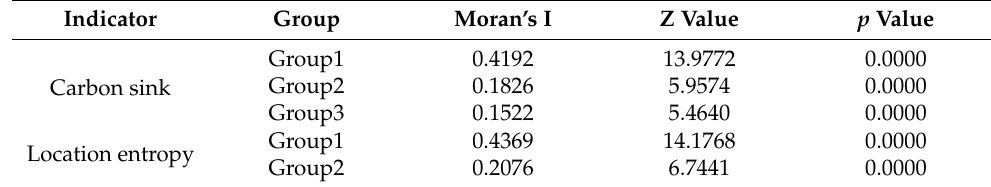
Table 5. Moran’s I index of carbon sink performance of aggregated green